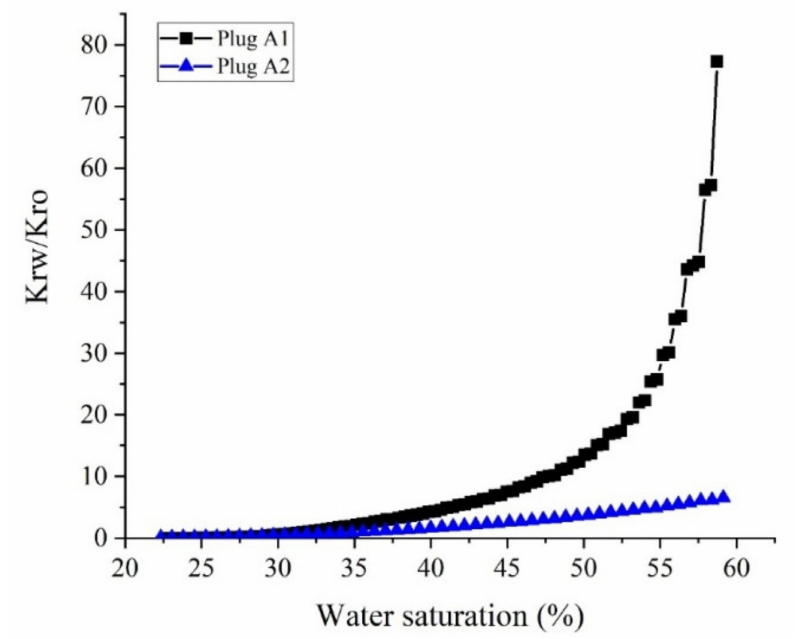
Figure 20. The ratio of water to oil relative permeability ( K rw / K ro ) for core samples A1 and A2 at overlapped water